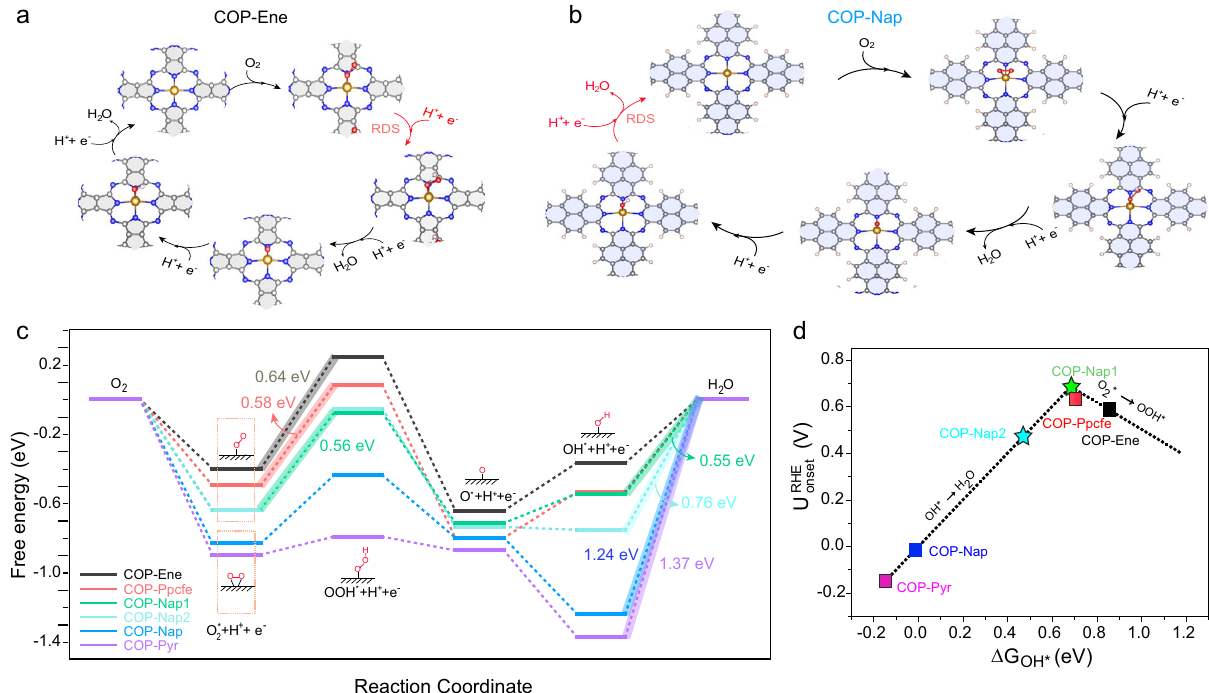
Fig. 6 Schematic diagram of rate-determining step transition. a , b Proposed ORR reaction scheme with the intermediates towards COP-Ene ( a ) and COP- Nap ( b ). RDS is a rate-determining step. The blue, gray, red, pink, and golden spheres represent N, C, O, H, and Fe, respectively. c The Free energy diagram of COP-Ene, COP-Ppcfe, COP-Nap1, COP-Nap2, COP-Nap, and COP-Pyr at equilibrium electrode potential. d The volcano plot of onset potential versus adsorption energy of